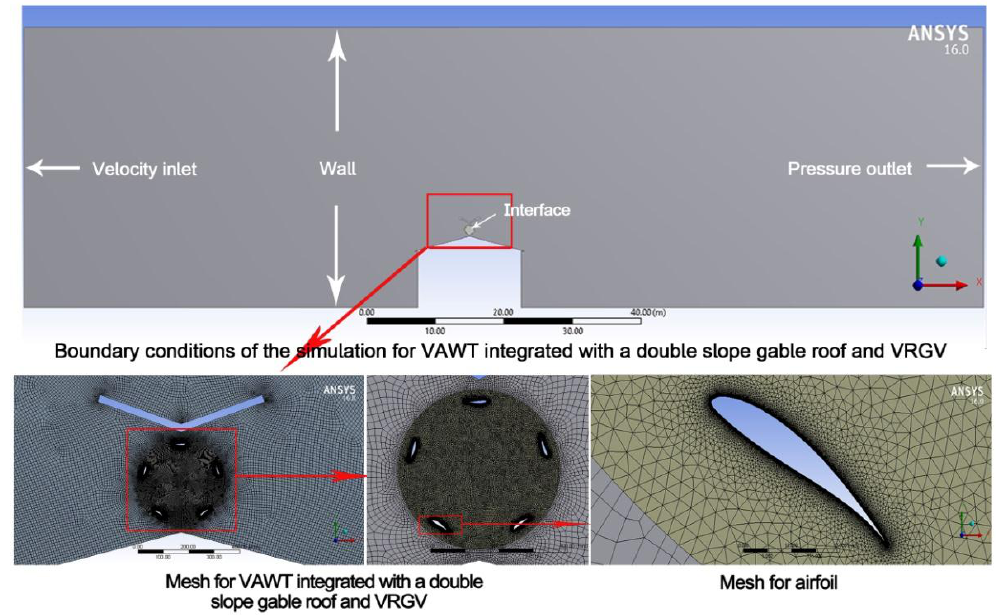
Figure 19. Geometry, boundary conditions and mesh used for the simulation model (VAWT integrated double slope roof with VRGV).